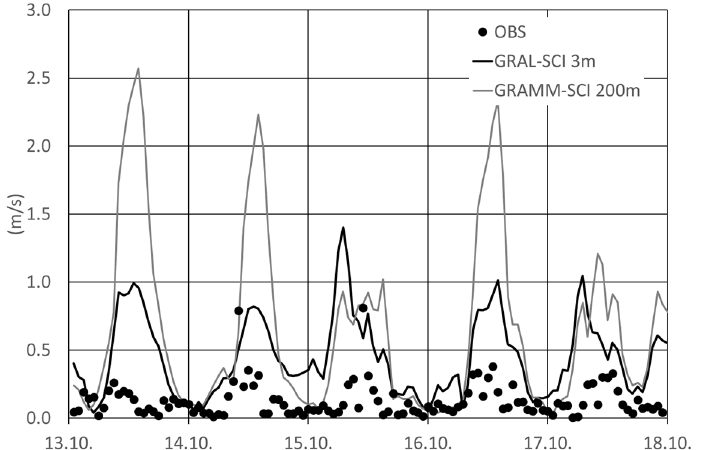
Figure 12. Observed and modelled wind speeds at the monitoring station WN139 in the Feldbach domain using the microscale flow-field model implemented in GRAL-SCI.